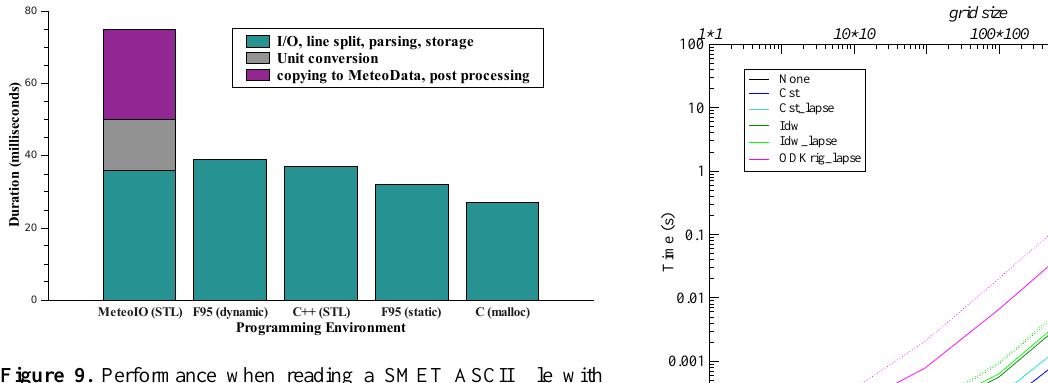
Figure 9. Performance when reading a SMET ASCII file with 1 year of hourly data into memory.